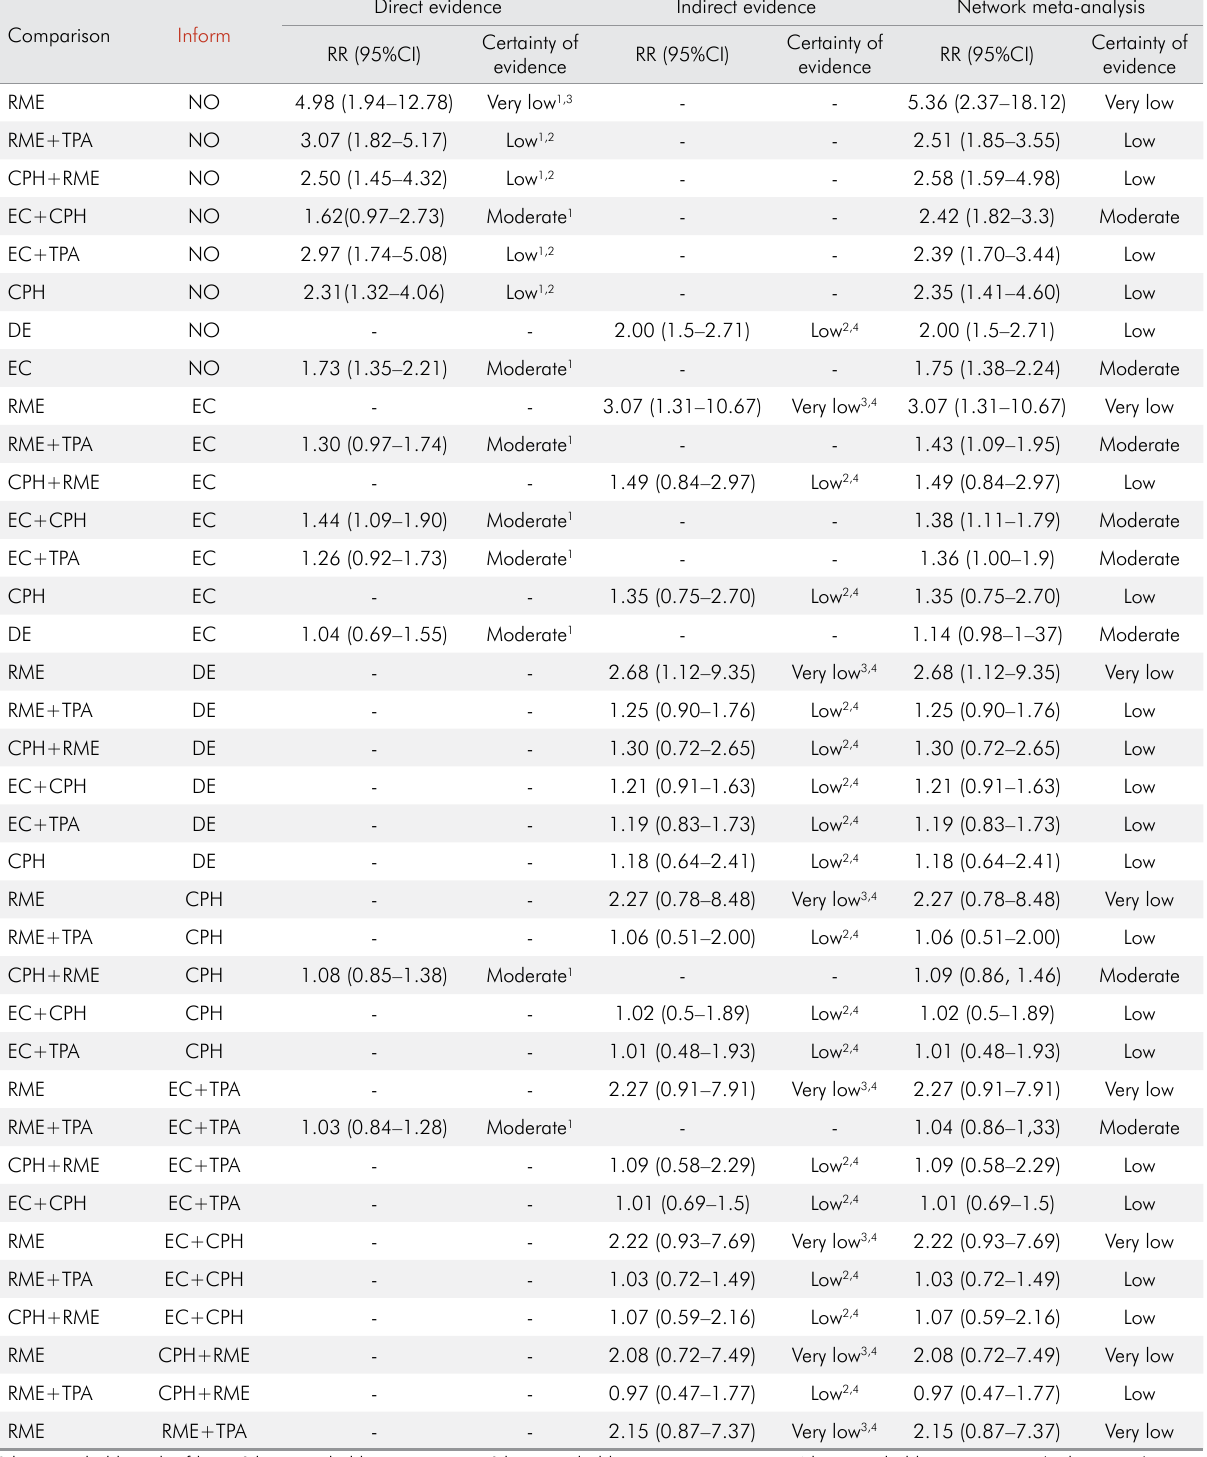
Table 6. Assessment of the certainty of